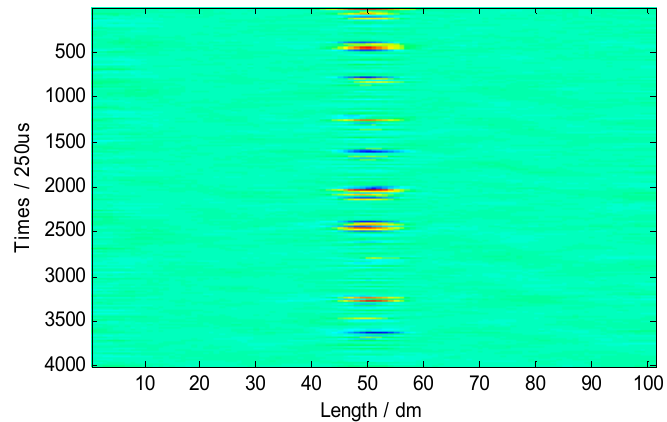
Figure 2. 2D diagram of distributed vibration signals.